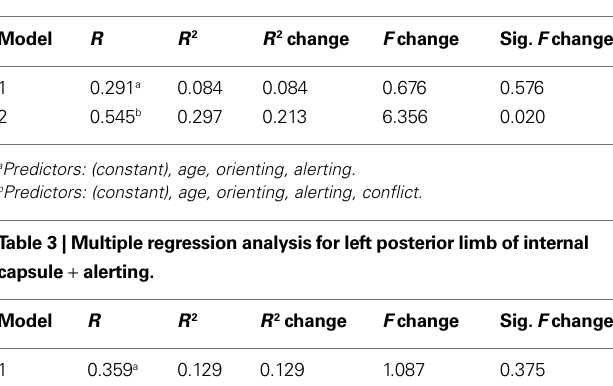
Table 2 | Multiple regression analysis for left anterior corona radiata + confl ict.